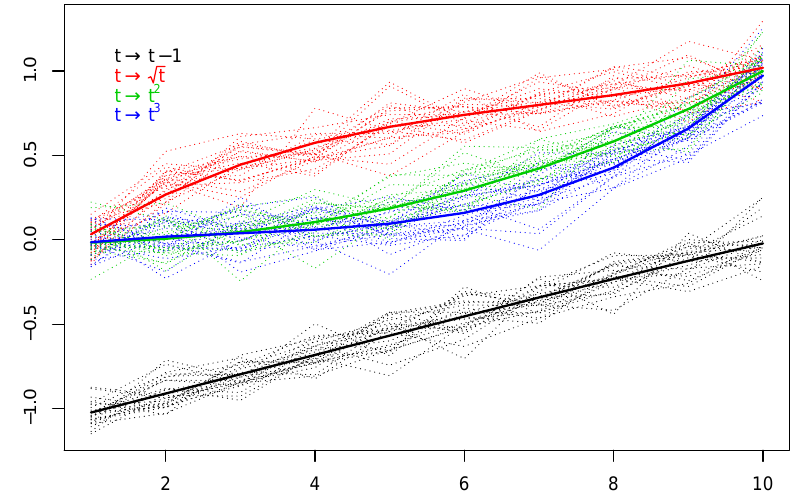
Figure 3. All curves (dotted lines) and cluster centres’ curves (plain lines) obtained with the fscm algorithm for the simulated Sample 2. Clustering becomes more difficult between curves (e.g., blue and green curves), but the algorithm still performs well to figure out the underlying shapes.